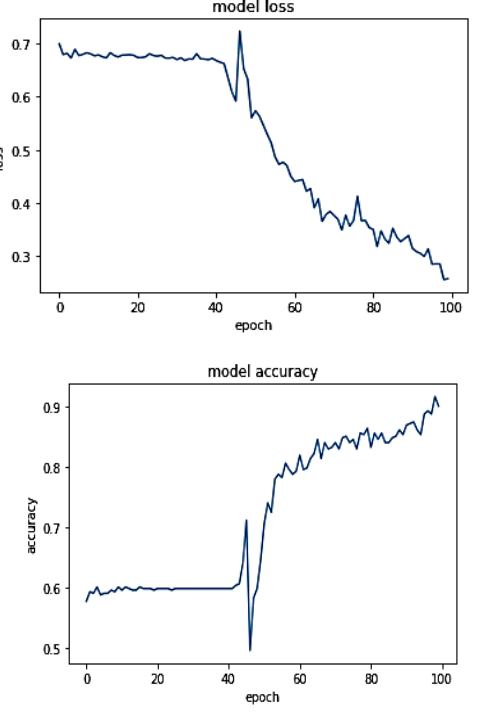
Fig. 5. Loss and accuracy plot of stacked GRU model obtained over epochs.